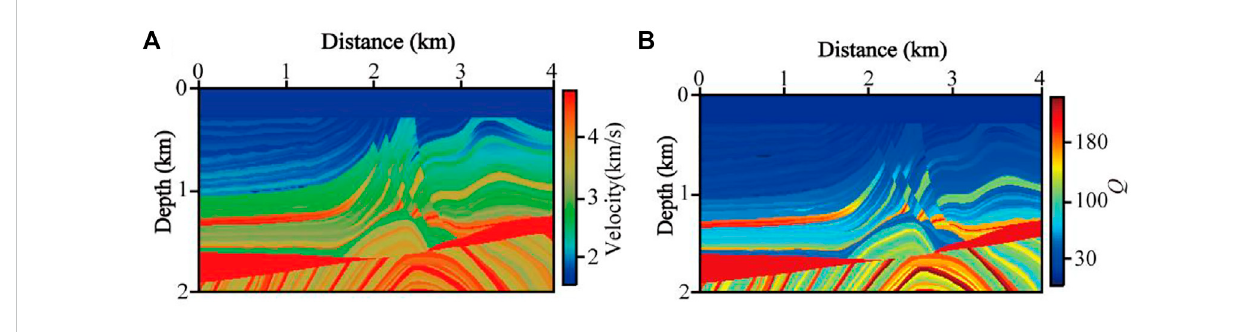
FIGURE 5 Marmousi (A) velocity and (B) Q model.